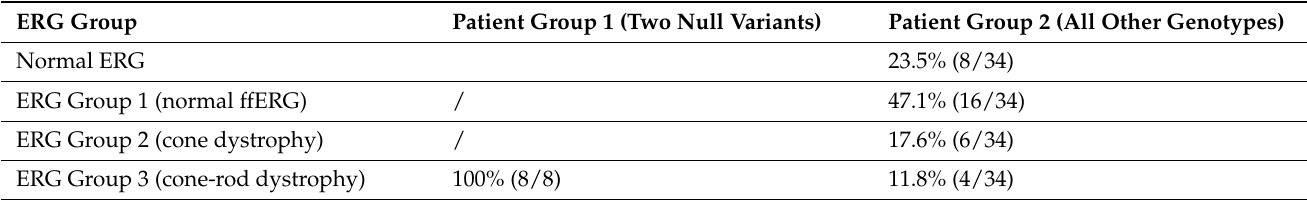
Table 2. Distribution of patients according to the traditional ERG